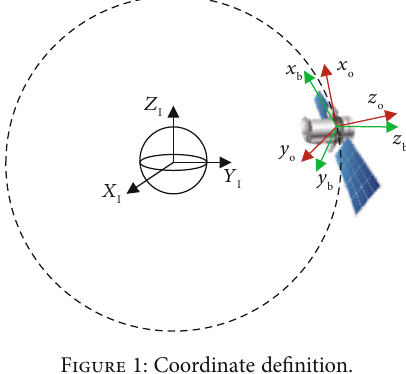
Figure 1: Coordinate de fi